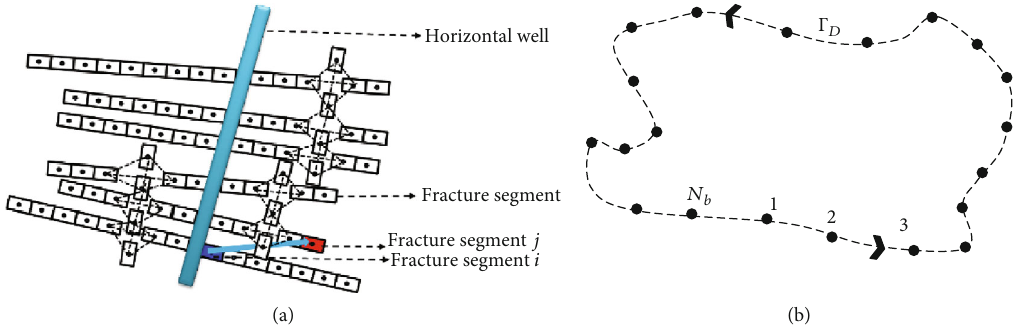
Figure 2: (a) Schematic of the discrete fracture model. (b) Schematic of discrete